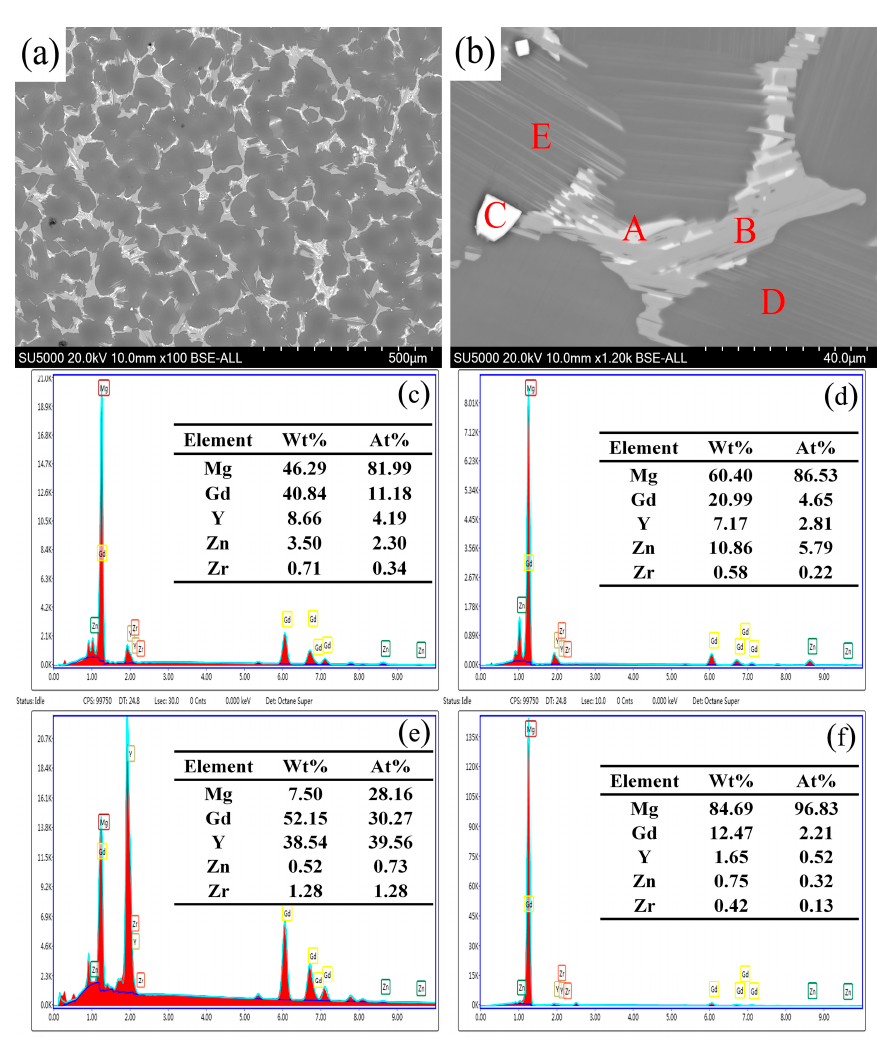
Figure 3. XRD patterns of Mg-12.0Gd-4.5Y-2Zn-0.4Zr in as-cast and as-homogenized states.